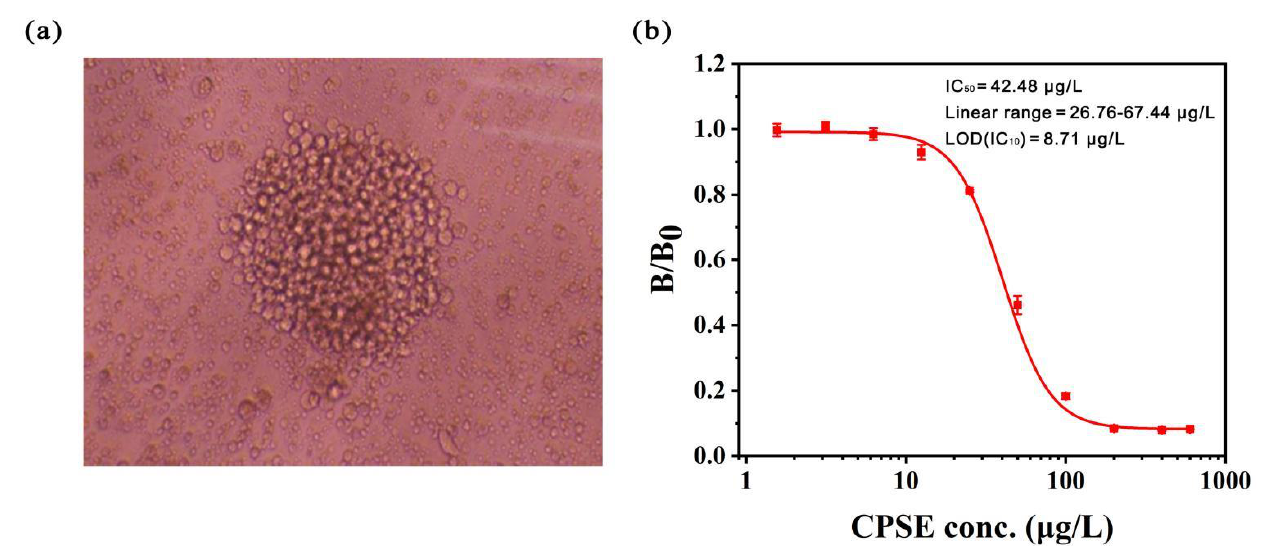
Figure 3. ( a ) The morphology of cells after fusion. ( b ) Calibration curve for determination of CPSE. Table 1. Specificity evaluation of mAb.